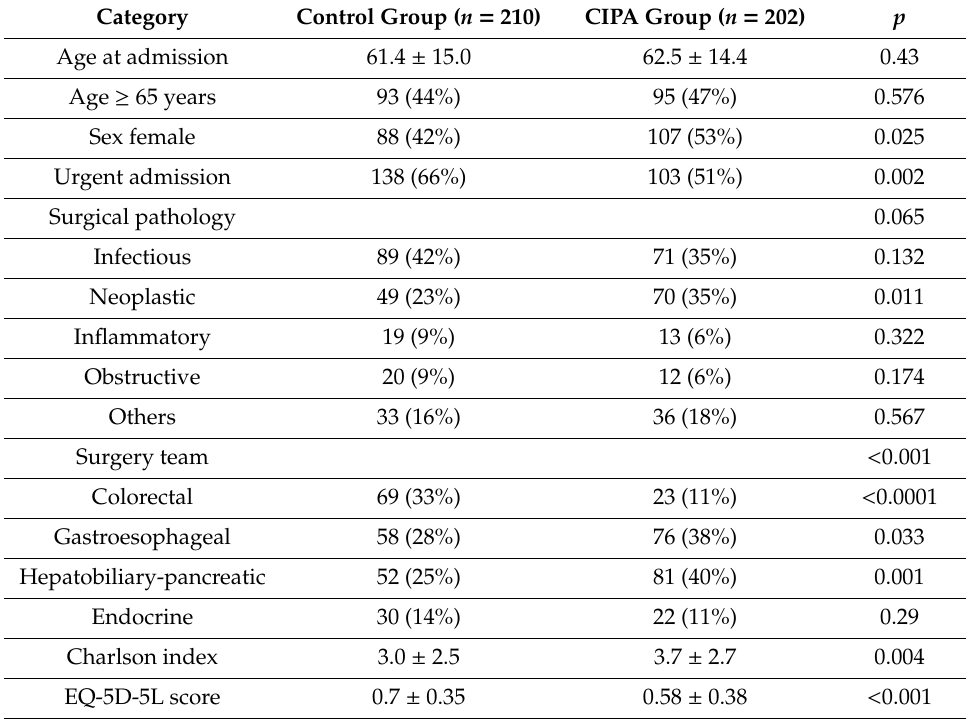
Table 1. Baseline sample data.